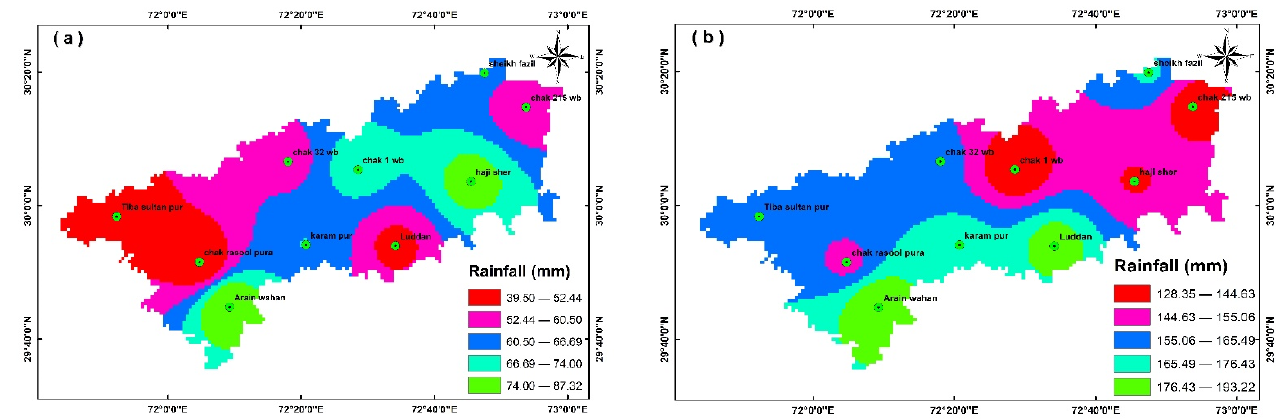
Figure 11. Maps of mean rainfall from 1984 to 2020 ( a ) Rabi and ( b ) Kharif season.